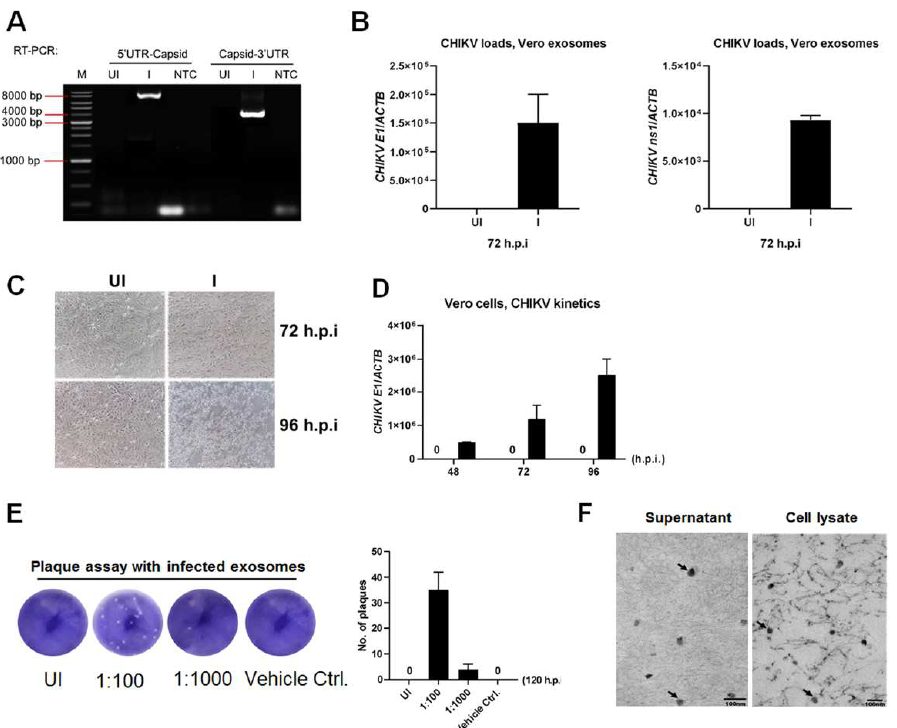
Figure 3. Exosomes derived from CHIKV − infected Vero cells contained viral genomic elements and are infectious. ( A ) An illustration of an agarose gel represents the overlapping amplicon product of all fragments from the entire CHIKV genome in exosomes derived from 5 MOI CHIKV − infected Vero at 72 h.p.i. The cDNA template was derived from the total exosomal RNA. All fragments display the amplification of the full − length CHIKV genome in each part. UI and I indicate CHIKV − uninfected and CHIKV − infected groups, respectively. N indicates no template control. M indicates DNA marker. ( B ) qRT − PCR analysis exhibiting CHIKV E1 mRNA loads in exosomes derived from MOI 5 infected Vero cells at 72 h.p.i. ( C ) An equal dose of exosomes from CHIKV − uninfected or CHIKV-infected Vero cells were applied to naïve Vero cells. Cytopathic effects (CPEs) were observed and daily noted via a bright-field inverted microscope. ( D ) qRT − PCR analysis revealing CHIKV loads in CHIKV − infected Vero cells at indicated time points. ( E ) Quantitative measurement of the plaque number on Vero cells treated with exosomes from CHIKV − uninfected or CHIKV − infected Vero cells. The column graph showed the CHIKV titer in the PFU/mL unit that was counted by PFU assay. ( F ) CHIKV was observed under a transmission electron microscope (TEM) from the cell culture medium and cell lysates of exosome infection naïve Vero cells. The black arrow indicated the CHIKV virions that were visual with a polymorphic giant form and many cores lining inside under TEM from both cell culture medium ( left ) and cell lysates ( right ) collected at 72 h.p.i. The virion size